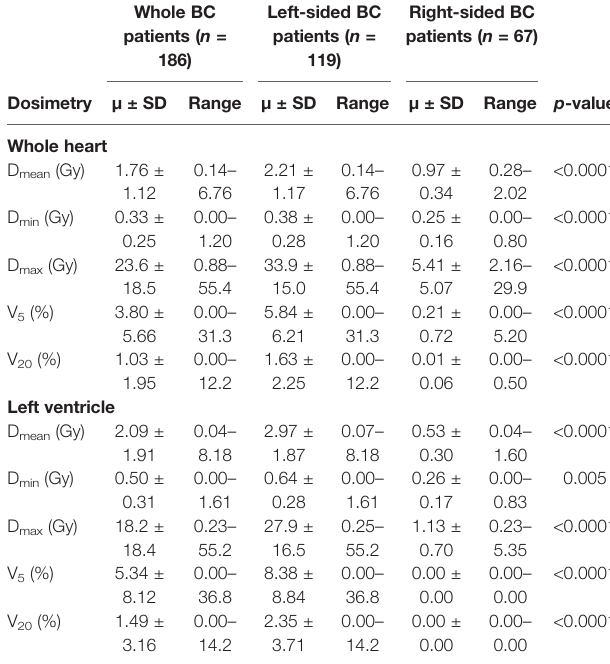
TABLE 2 | Dose-volume parameters for the whole heart and left ventricle. Whole BC patients ( n =